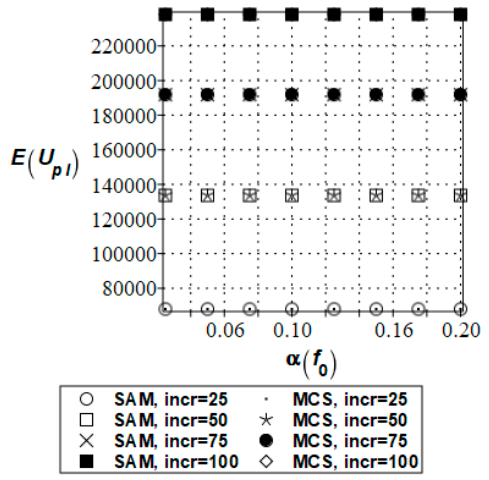
Figure 6. Expected values of plastic energy fluctuations.